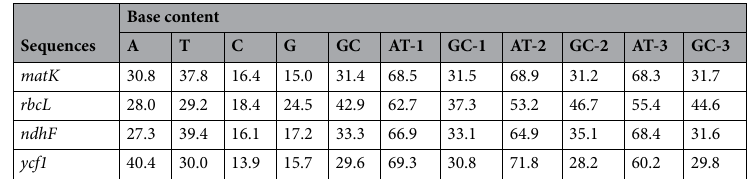
Table 1. The nucleotide base frequencies analysis of candidate nucleotide sequences in Orchidaceae